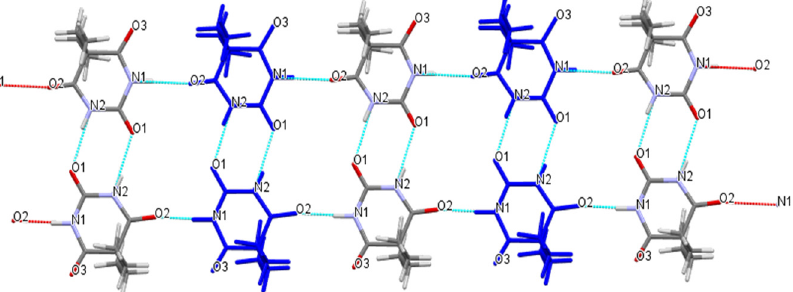
Figure 6 . Cooperative N–H···O hydrogen-bonded linear chain supramolecular homosynthons ex- Figure 6. Cooperative N–H ··· O hydrogen-bonded linear chain supramolecular homosynthons hibited in the crystal structure of barbital. exhibited in the crystal structure of barbital.